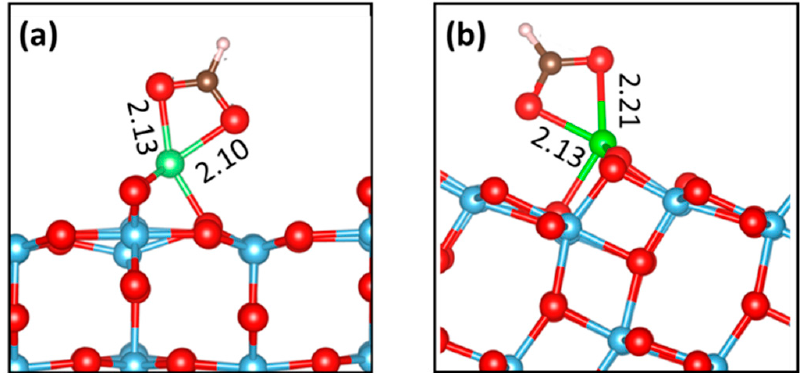
Figure 4. Side sketches of Ti adatoms coordinated by a bidentate chelating formate anion at ( a ) the rutile surface and ( b ) at the anatase surface. Atom colors are the same as in Figure 1. The Ti adatom is shown as a green sphere. Distances in Å refer to calculations with U = 3.5 eV.